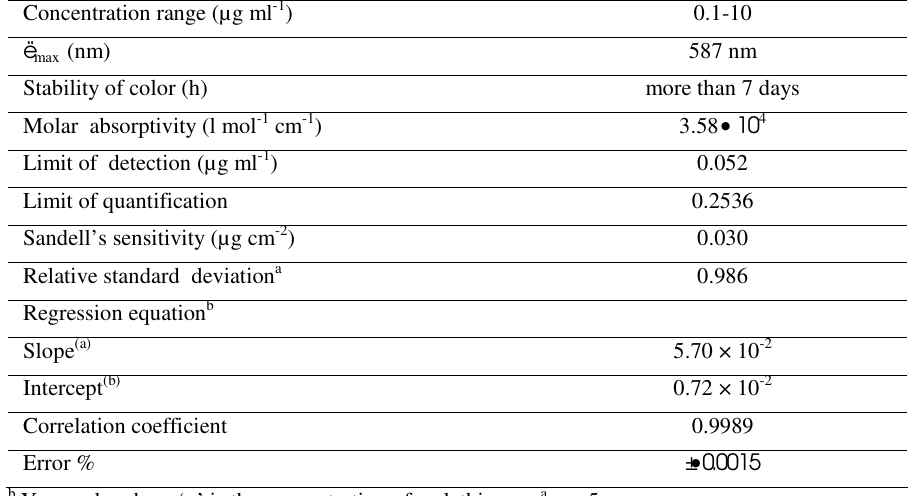
Table 1 Optical characteristics precision and accuracy of the method using gentian